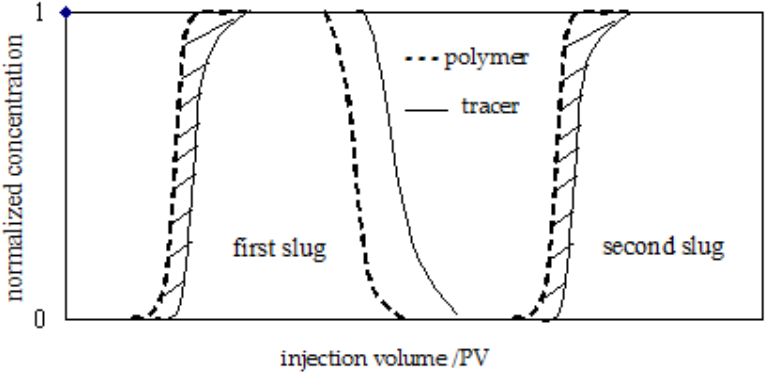
Figure 7. The schematic diagram of the Double-Slug experimental results.